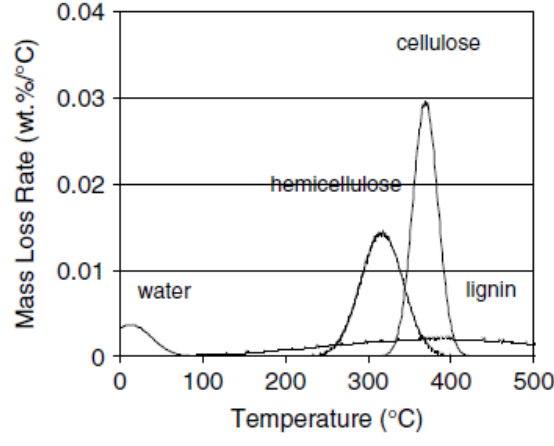
Figure 3. Decomposition rate of individual biomass components with pyrolysis temperature